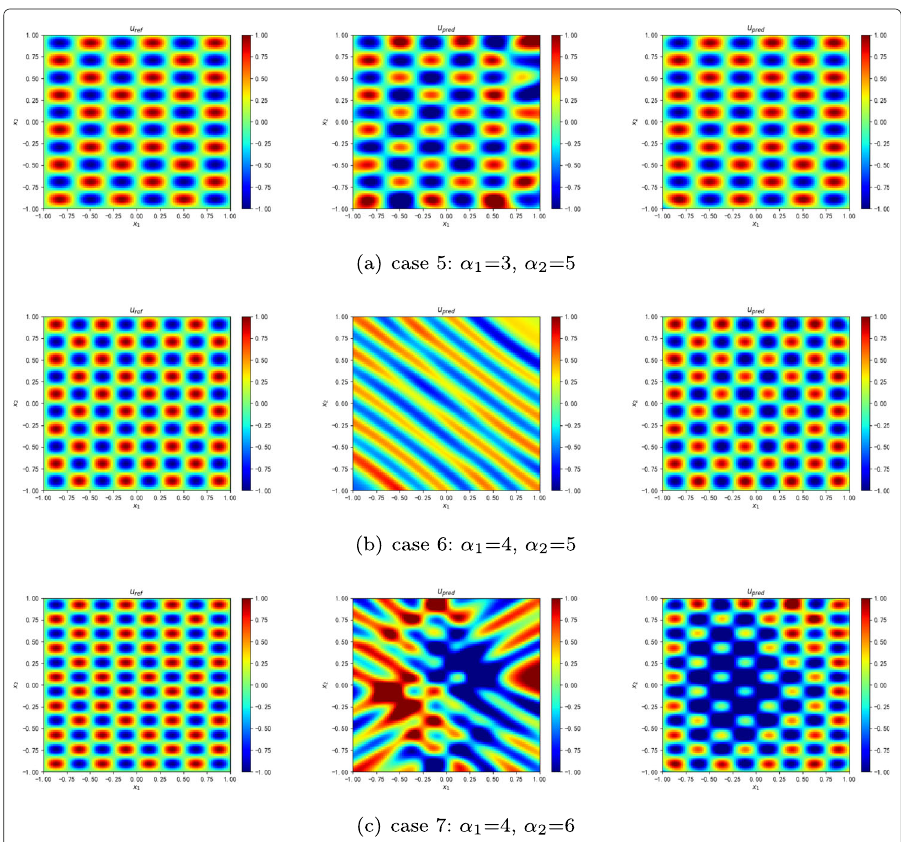
Fig. 4 Prediction results of PINN-anneal on Helmholtz benchmarks (case 5-7). Left : reference solution. Middle : predicted solution using random initialization. Right : predicted solution using transfer learning